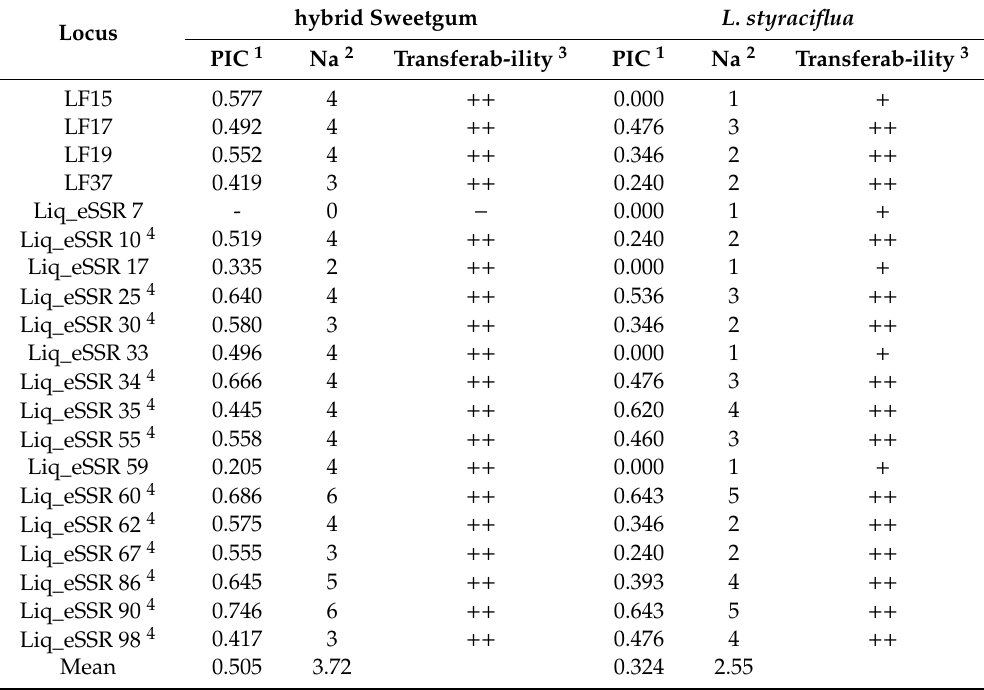
Table 5. Cross-species amplification of 20 SSR loci in other Liquidambar species as demonstrated by two genetic diversity indices (Na and PIC). hybrid Sweetgum L. Locus